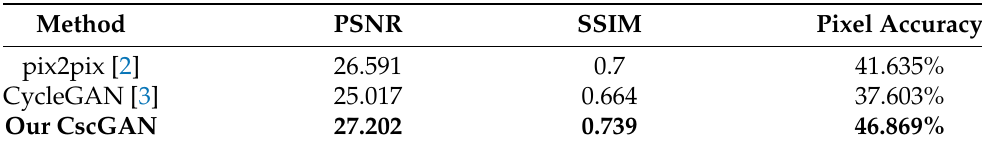
Figure 8. Visualization generation results via different methods on maps dataset. Table 3. Comparison of the state-of-the-art methods on the maps dataset. The best results are highlighted in